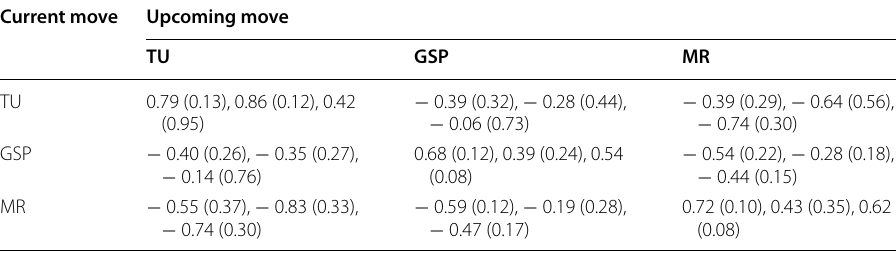
The values are shown as Mean